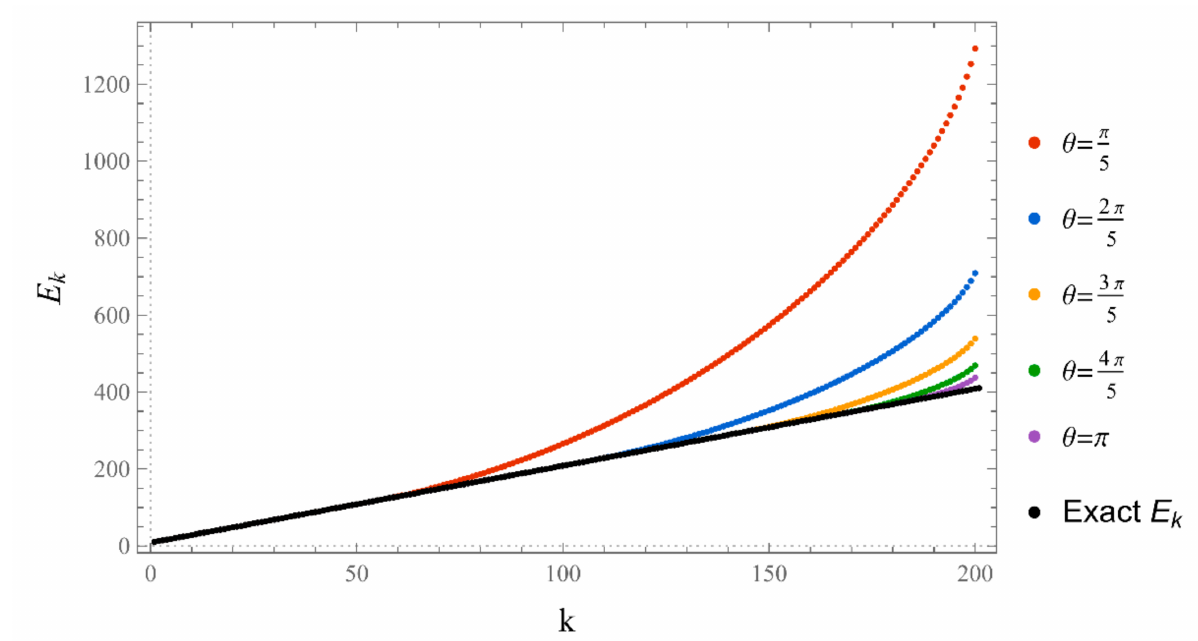
Figure A17. The k th zero of P N ( E ) vs k for N = 200. We took ω = 1, µ = 5, for different values of θ . This shows how the plot have better convergence as θ increases.